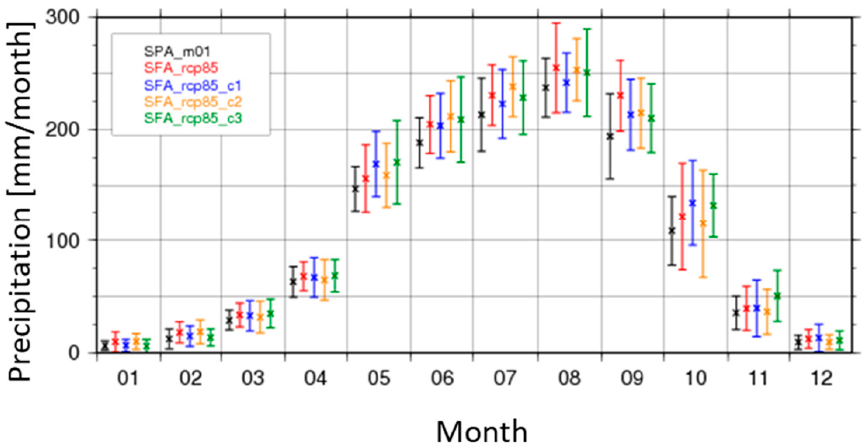
Figure 5. Monthly precipitation variability for the considered present and future climatic durations (cross: 25-year average, bar: ±1 σ range).